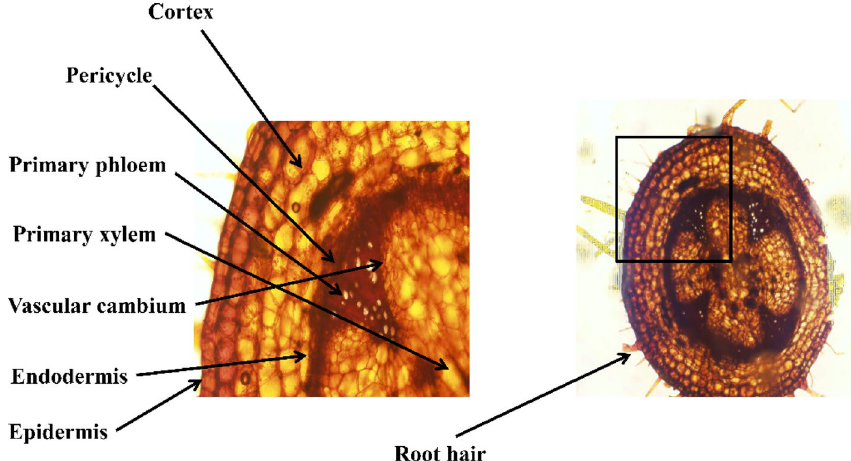
Figure 1. Structure of the tomato stem made by freehand section using paraffin sectioning